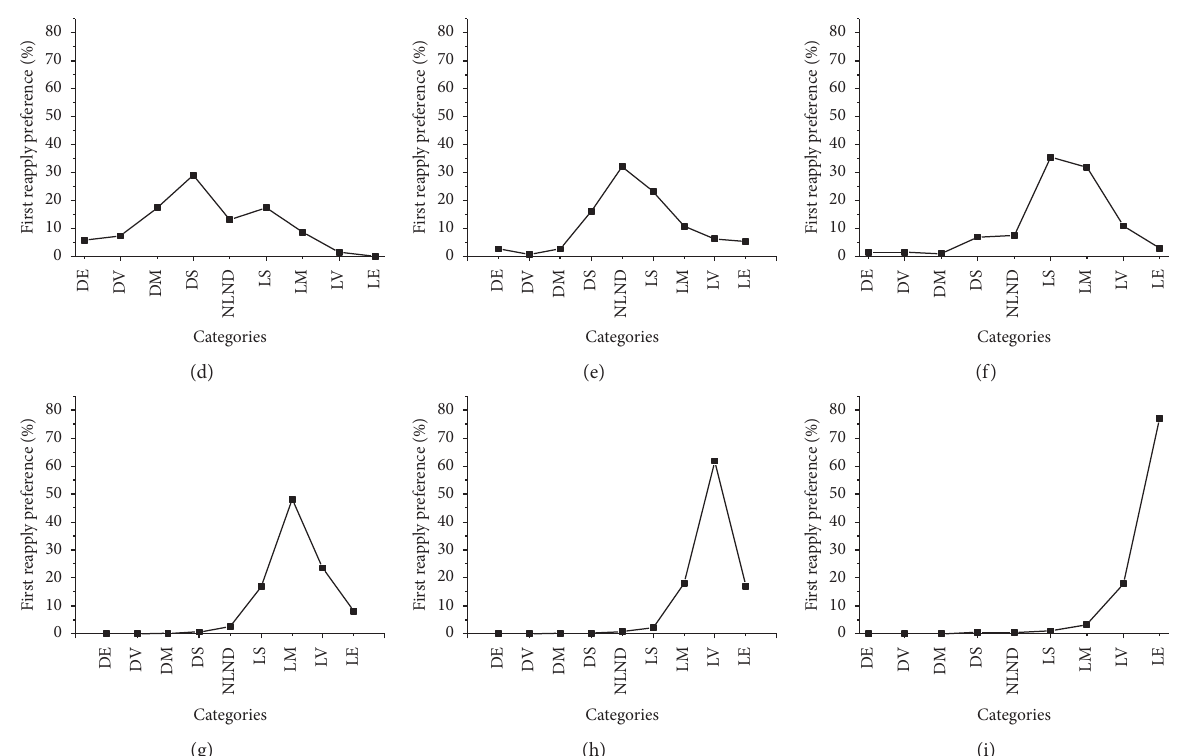
Figure 16: Variability of the responses of Experiment 1 compared to the responses of the first reapplication according to each category of the scale. (a) Preference in Experiment 1: dislike extremely. (b) Preference in Experiment 1: dislike very much. (c) Preference in Experiment 1: dislike moderately. (d) Preference in Experiment 1: dislike slightly. (e) Preference in Experiment 1: neither like nor dislike. (f) Preference in Experiment 1: like slightly. (g) Preference in Experiment 1: like moderately. (h) Preference in Experiment 1: like very much. (i) Preference in Experiment 1: like extremely.